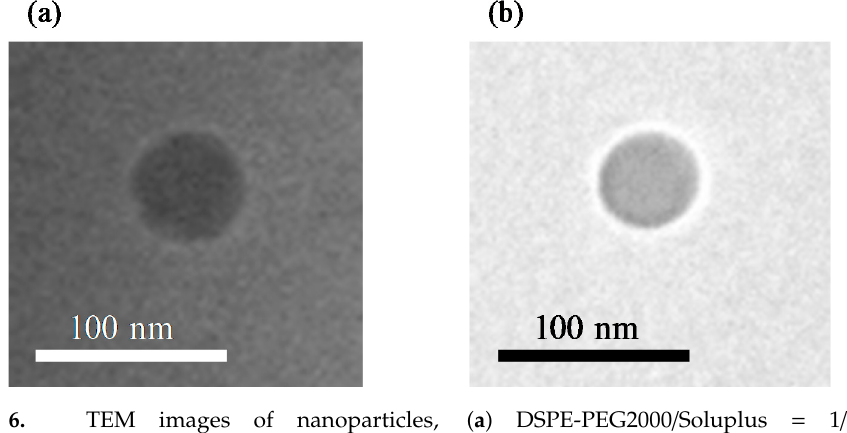
Figure 6. TEM images of nanoparticles, ( a ) DSPE-PEG2000 / Soluplus = 1 / 1, ( b ) DSPE-PEG2000 / Soluplus = 1 / 2.